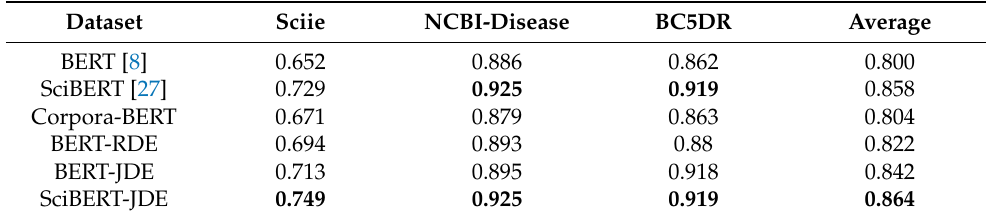
Table 3. Named Entity Recognition Experimental